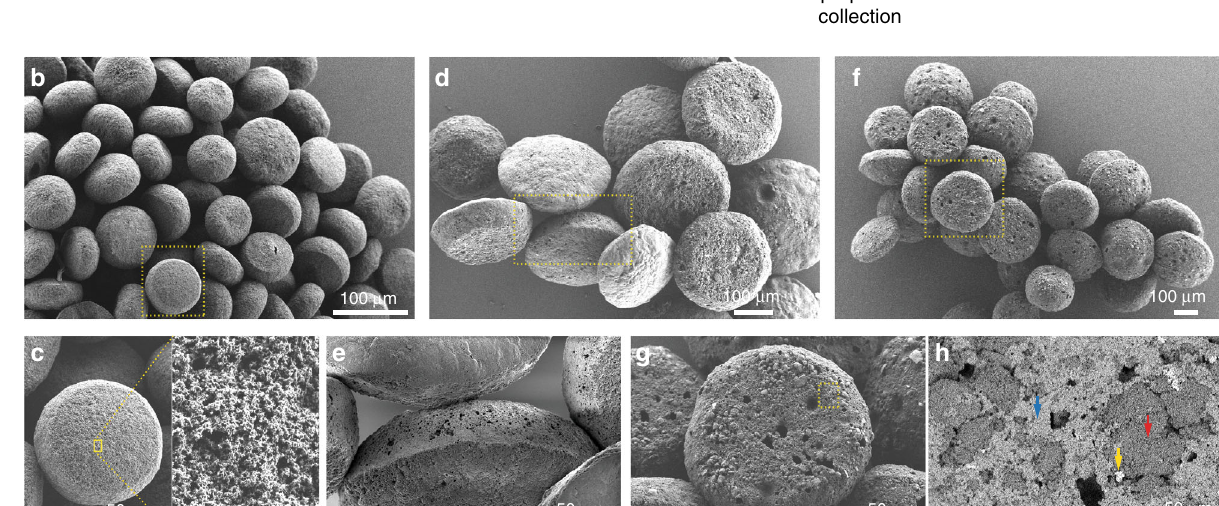
Fig. 4 Scalability of the process with different and multiple types of nanoparticles. a Demonstration of the fl exible and handy scalability of supraparticle fabrication on OTMS/OTS surface. As self-lubrication and the robust surfaces allow for a simple harvesting process and to recycle the surfaces. b – h SEM images of the generated supraparticles. b A large quantity of generated porous TiO 2 supraparticles. c A close-up view of the porous surface of the particle in b . d Bunches of porous supraparticles made by TiO 2 (0.05 vol%) and SiO 2 (0.05 vol%) nanoparticles. e A close-up of the side of the particle in d . f Bunches of porous supraparticles with three different nanoparticles, TiO 2 (0.06 vol%), SiO 2 (0.03 vol%), and Fe 3 O 4 (0.01 vol%). g , h present a sequence of two zooms into the particle in f . In h , the supraparticle surface was imaged with energy-selective backscatter (EsB) detector to present different materials in different grey levels: Fe 3 O 4 (bright spots pointed by the yellow arrow), TiO 2 (light grey regions by the blue arrow), SiO 2 (dark grey regions by the red arrow). Darkness indicates holes without